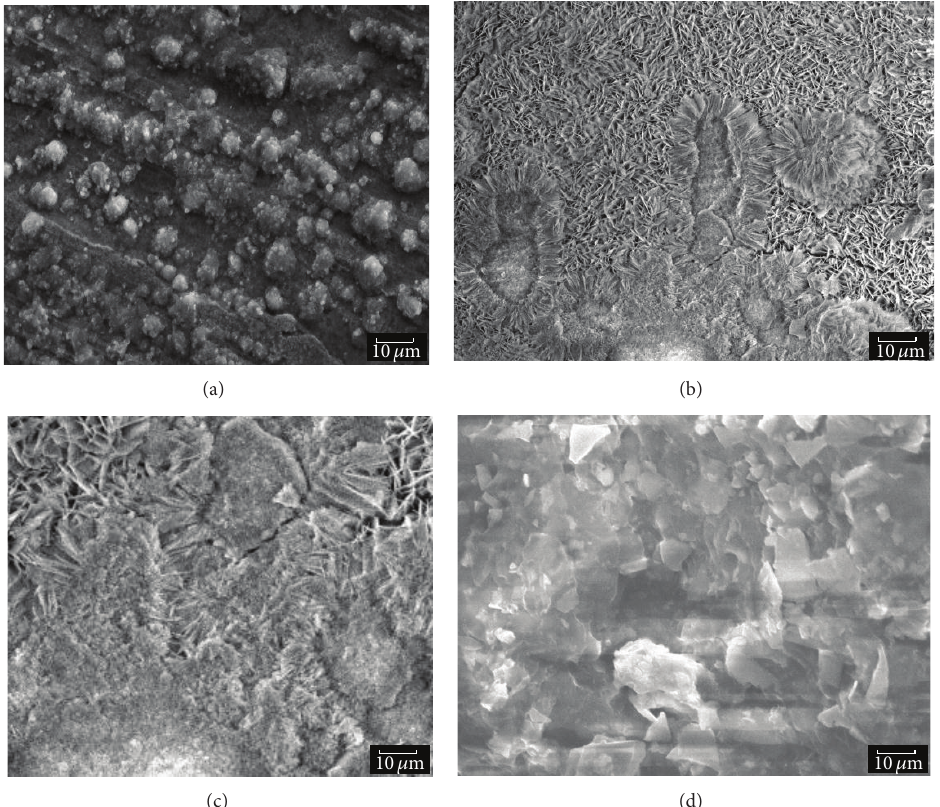
Figure 11: SEM images of galvanized steel immersed in CRS solution under different temperatures in 0.1 MPa after 14 days, (a) 273 K; (b) 293 K; (c) 313K; (d) 333